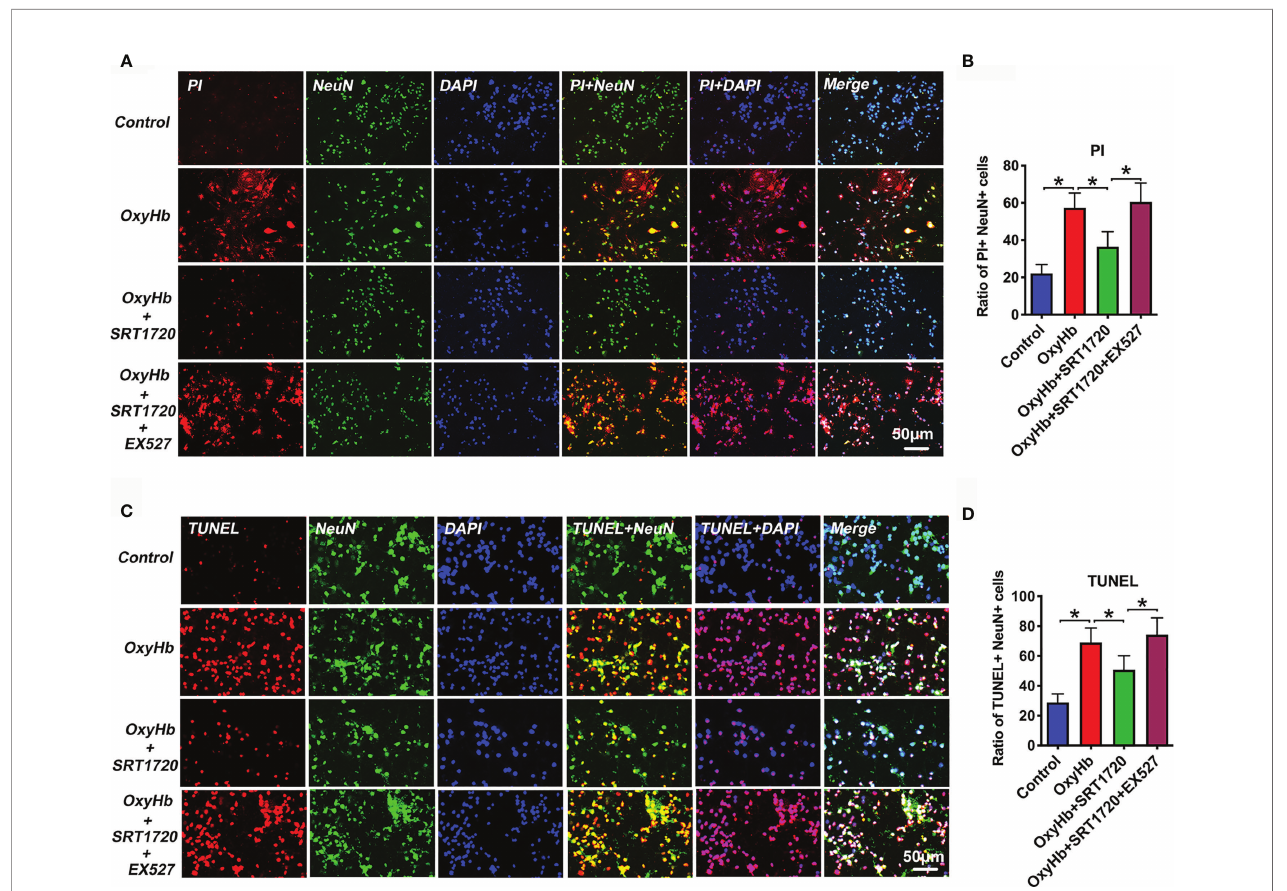
FIGURE 10 | Effects of SRT1720 on PI and TUNEL staining in vitro . Representative photomicrographs (A) and quanti fi cation (B) of PI staining in primary cortical neurons. Representative photomicrographs (C) and quanti fi cation (D) of TUNEL staining in primary cortical neurons. Bars represent the mean ± SD. * P <